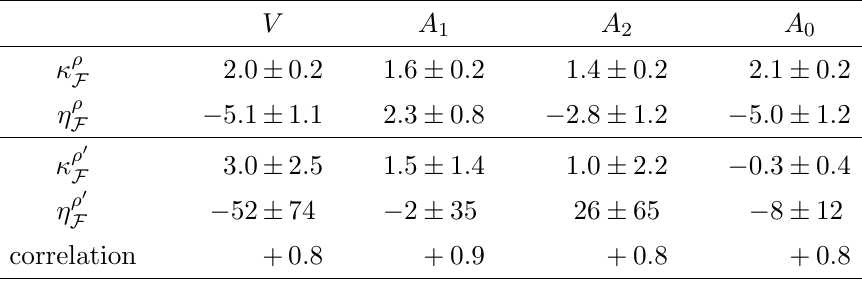
Table 2 . Results of the (cid:12)t to the (cid:26) 0